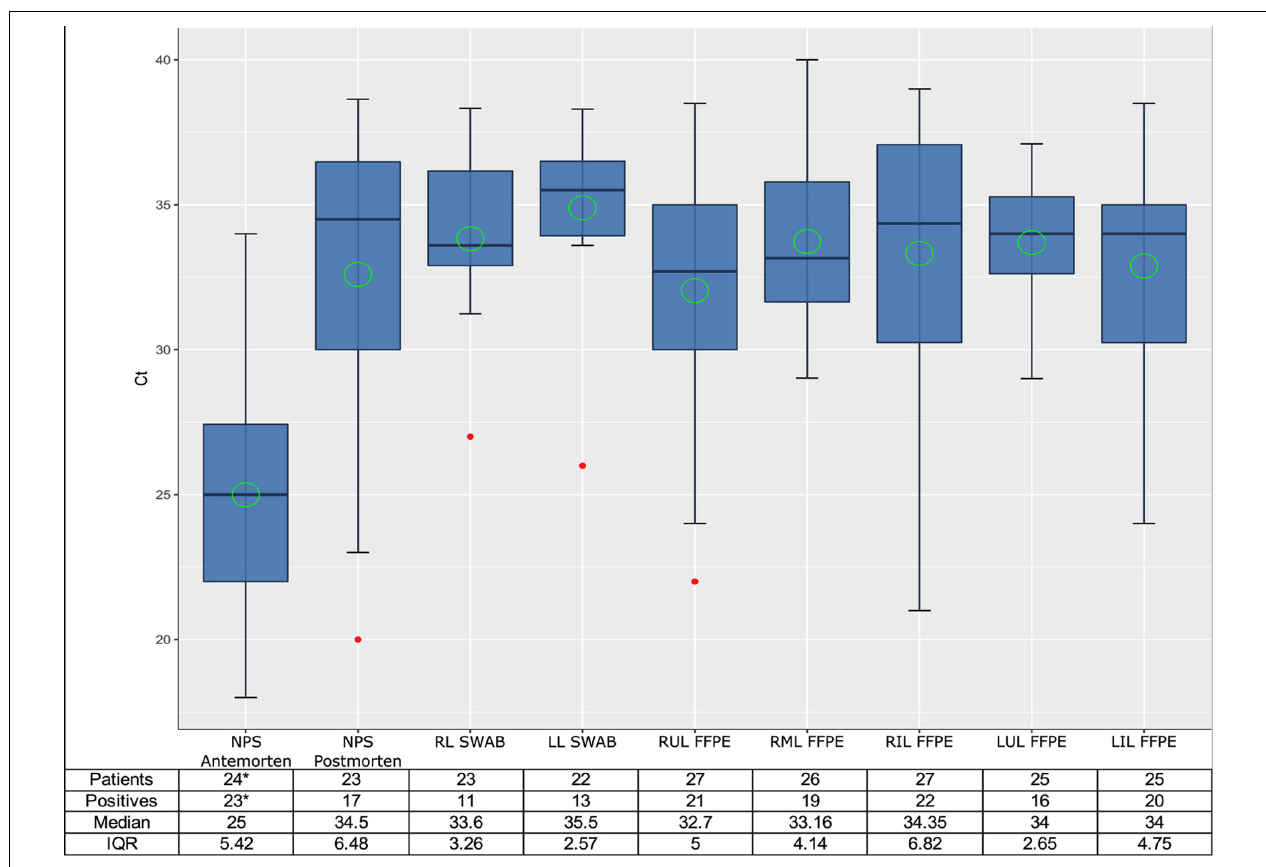
FIGURE 4 | Box plot of SARS-CoV-2 cycle threshold values of the different types of samples. Median is shown as a black line, mean as a green circle and the outliers as red points. ANOVA: Pr( > F) = 4.04e–12***. Ct, cycle threshold; NPS, nasopharyngeal; RL, right lobe; LL, left lobe; RUL, right upper lobe; RML, right medium lobe; RIL, right inferior lobe; LUL, left upper lobe; LIL, left inferior lobe; IQR, interquartile range. *Three positive patients did not have the Ct values recorded. One additional patient had a negative result in our hospital, but a positive result in another